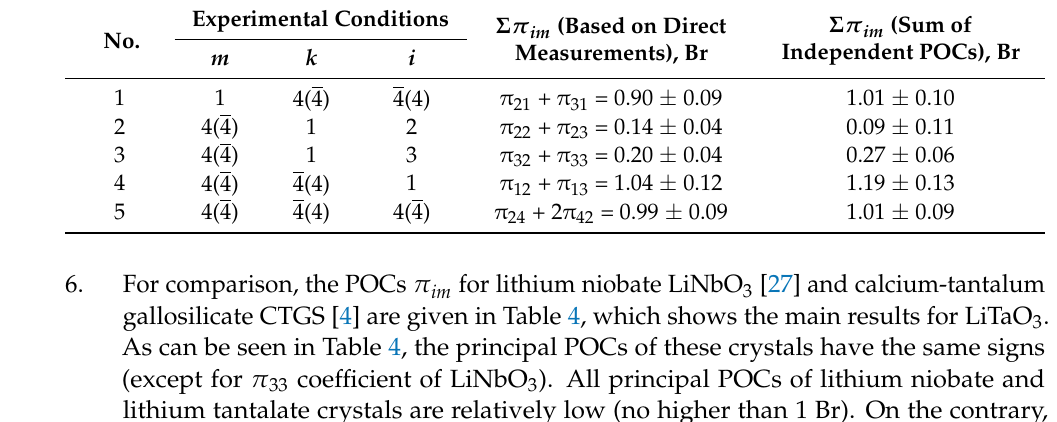
Table 5. Sums of POCs obtained on the sample of the X /45 ◦ -cut (LiTaO 3